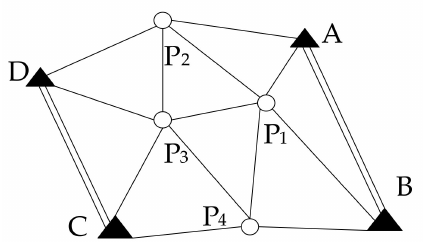
Figure 5. Schematic Diagram of the adjustment of the edge measuring network.